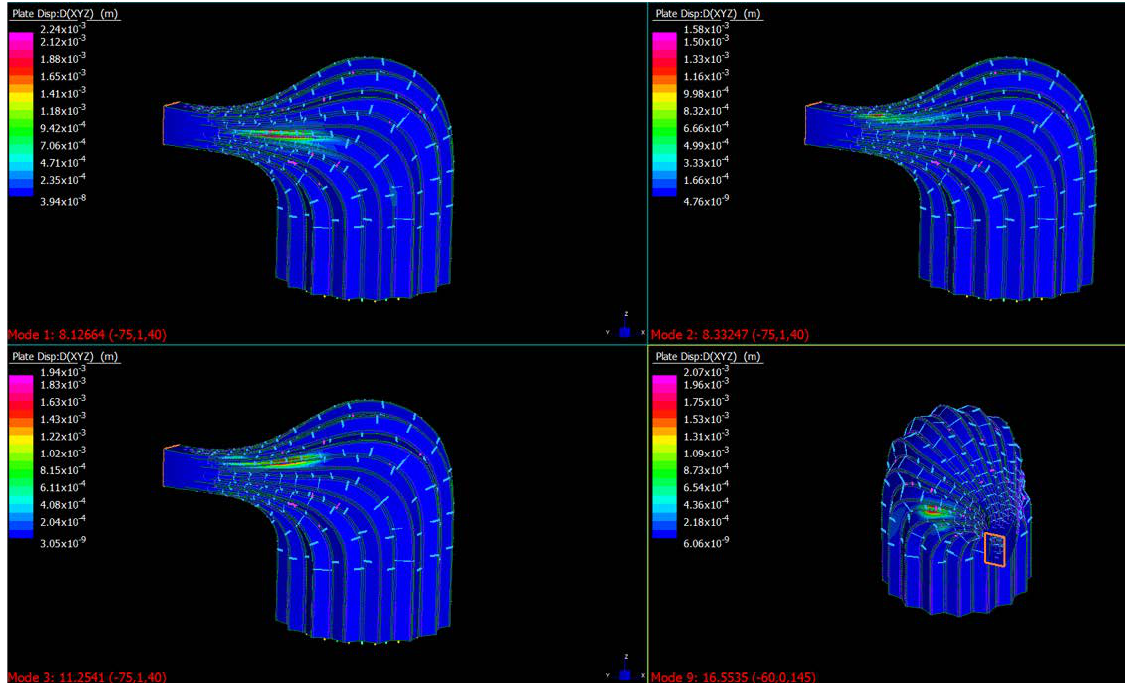
Fig. 6 First four buckling mode shapes Bombay